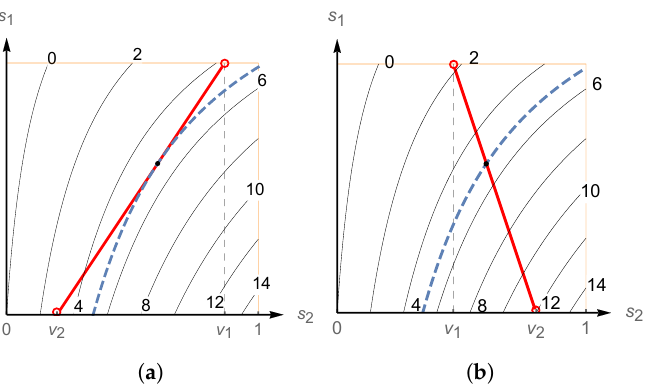
Figure A4. For G P 1 , plots ( a , b ) depict the first player’s attainable sets (the straight lines) for v = ( 13 ) and v = ( 7 ) , respectively. The thin lines correspond to the payoff levels equal to 0,2,...,14. , 3 , 4 5 5 15 15